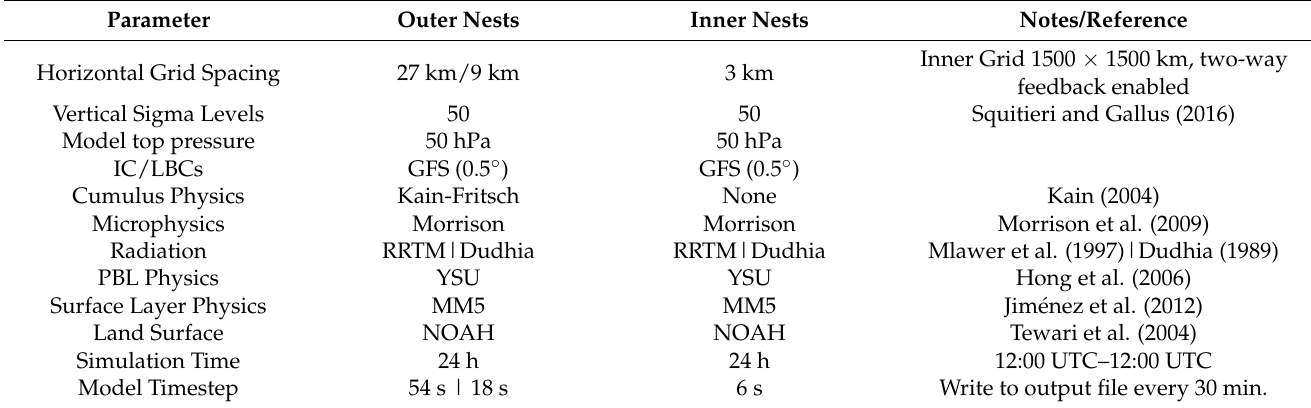
Figure 1. 3-km WRF Domain used in this study. Approximate locations of each event denoted by the circles. Green circles indicate MCS events, while blue circles denote non-MCS events. Table 1. WRF-ARW setup used for all 30 cases.